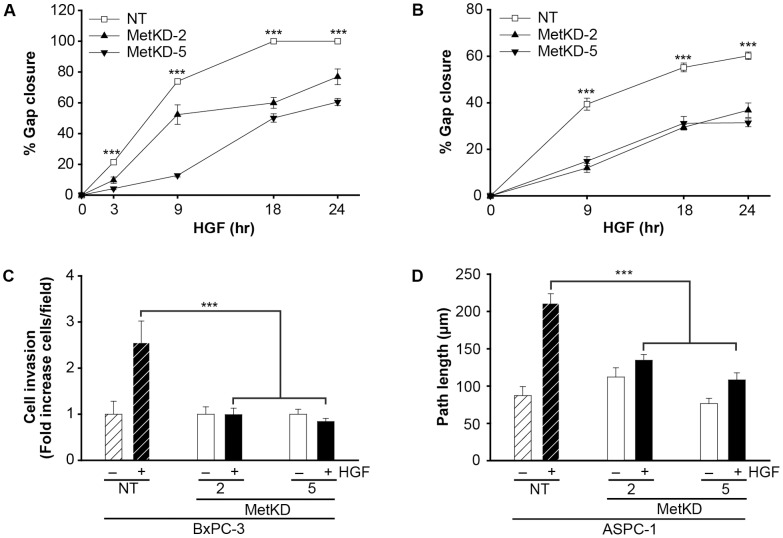
Decreased cell motility and invasion in vitro by Met knockdown.Serum-depleted, confluent NT or MetKD BxPC-3 (A) or ASPC-1 (B) cells were wounded with a scratch, six regions marked, and immediately imaged (0 hr) prior to treatment with HGF. Identical regions along the scratch were imaged after 3, 9, 18, and 24 hr and the values were normalized to the initial size of the scratch at 0 hr. Cell migration is reported as the % gap closure at each time point (***p<0.001; ANOVA, n = 3). MetKD reduces BxPC-3 cell invasion in response to HGF relative to control cells (C). Values represent the fold change in the number of cells/field and are reported as the mean +/− SEM (***p<0.001; ANOVA, n = 3). Live cell imaging of ASPC-1 MetKD cells plated on collagen I-coated glass bottom cell culture dishes show decreased cell migration in response to 100 ng/mL HGF (D). Images were collected every 2 min for a total of 120 min and data is expressed as the mean path length +/− SEM per condition (***p<0.001; ANOVA, n>30 cells).